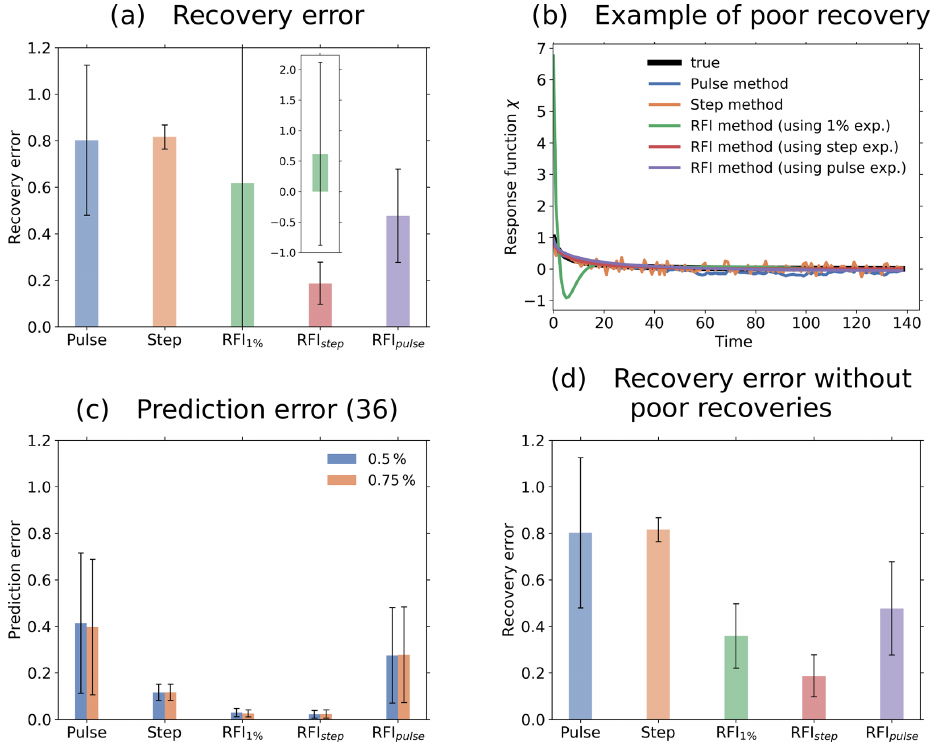
Figure 10. Quality of response function recovery by our RFI method excluding step 6 in Fig. 1 in comparison to the pulse and step method. Response function is recovered taking the individual response for each ensemble member. Subscripts at “RFI” indicate the experiment from which the response function was recovered with the RFI method. (a) Statistics of the recovery error; (b) example of poor recovery with the RFI algorithm; (c) statistics of the prediction error (Eq. 36); (d) statistics of the recovery error excluding for the RFI 1% the 6.5% of the recoveries with recovery error greater than 1. Once again, the RFI method gives better recovery and prediction errors than the pulse and step methods for the same responses. Without accounting for monotonicity, the variability in the quality of the recoveries from the 1% experiment increases substantially, but poor recoveries are obtained in only a few